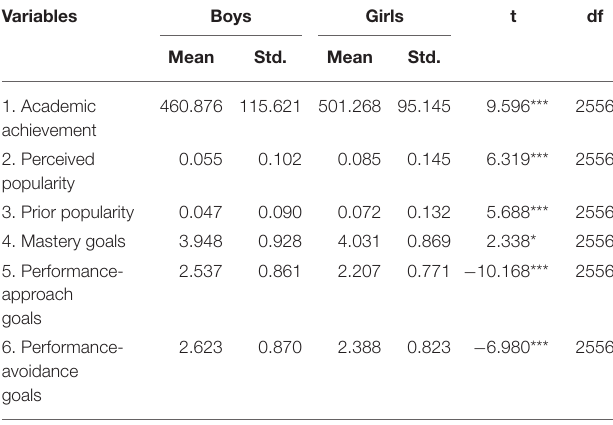
TABLE 1 | The difference tests of variables at level 1 for boys and